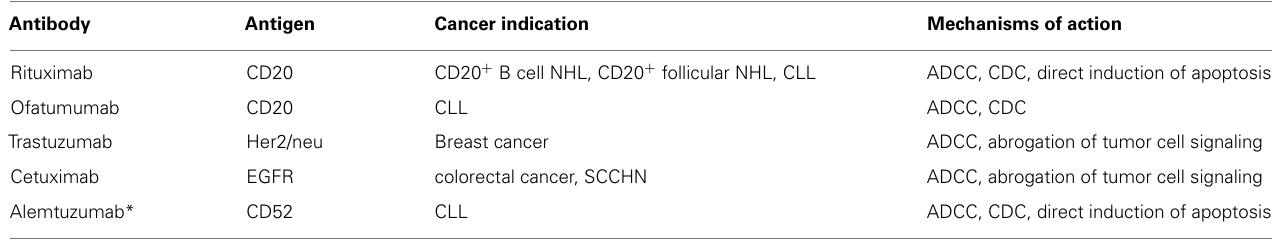
Table 1 |ADCC-mediating therapeutic antibodies currently FDA approved for cancer